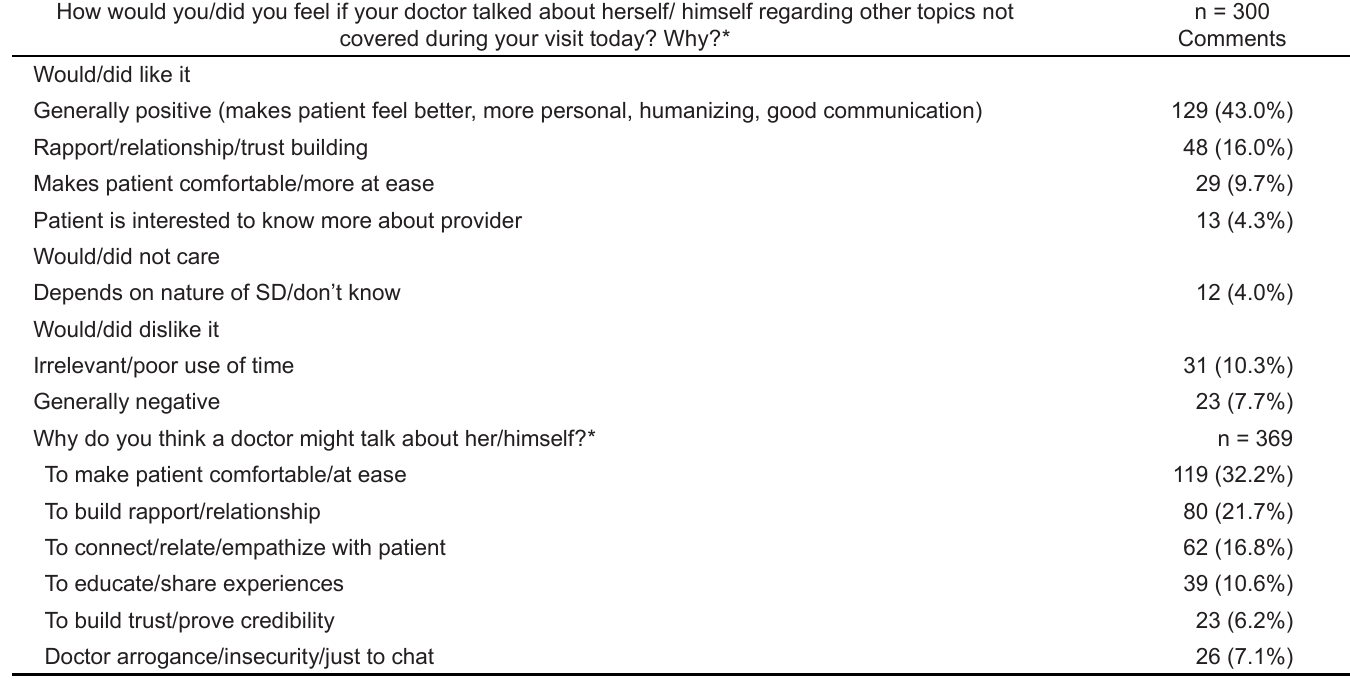
Table 4. Themes of open-ended responses in a study of the effect of provider self-disclosure on patient